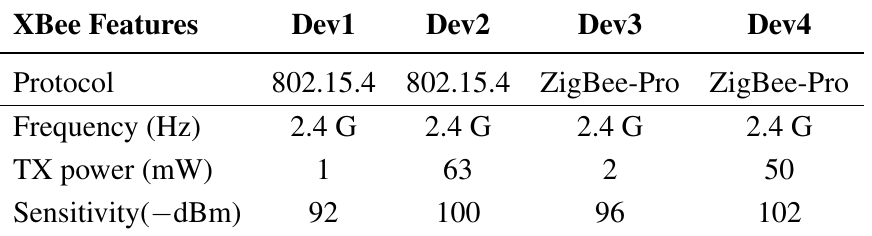
Table 2. Waspmote Transceiver Features and